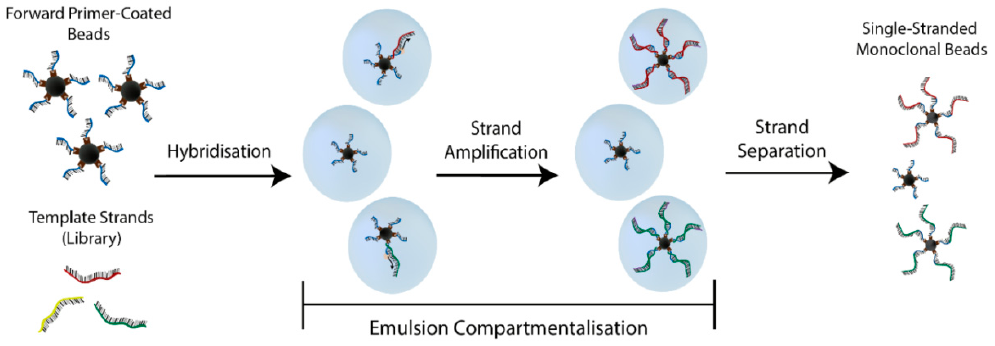
Figure 4. Schematic of bead-based ePCR. Step 1: Primer-coated beads and template library are combined in an emulsion, with one bead and one unique template strand per reacting droplet. Step 2: PCR is conducted within the droplets. Step 3: The emulsion is broken and double stranded library beads are magnetically collected. Step 4: By alkaline denaturation and magnetic separation single stranded monoclonal beads are formed. On average only 10% of droplets will contain sequences with as many as 80% of nucleotide coated beads being monoclonal [18].